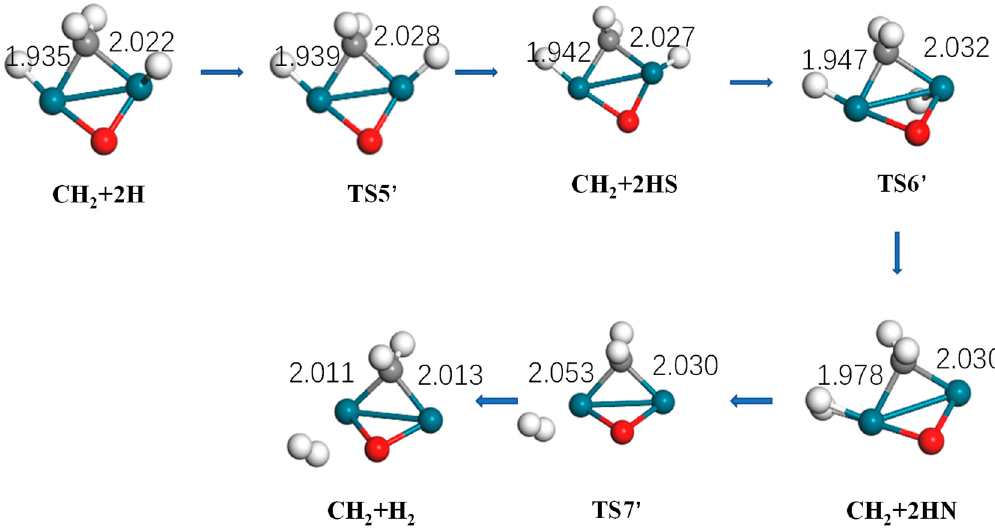
Figure 8. Optimized structure of reactants, intermediates, products, and the transition state of hydrogen generation by Pd 2 O (turquoise: Pd, gray: C, white: H).